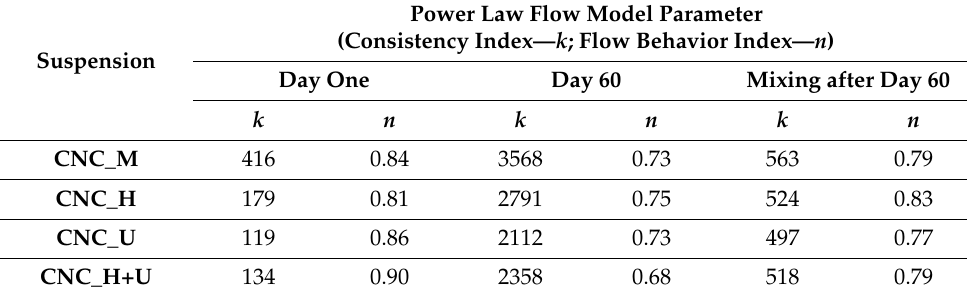
Table 1. The power law flow model parameters for the CNC suspensions. Power Law Flow Model Suspension